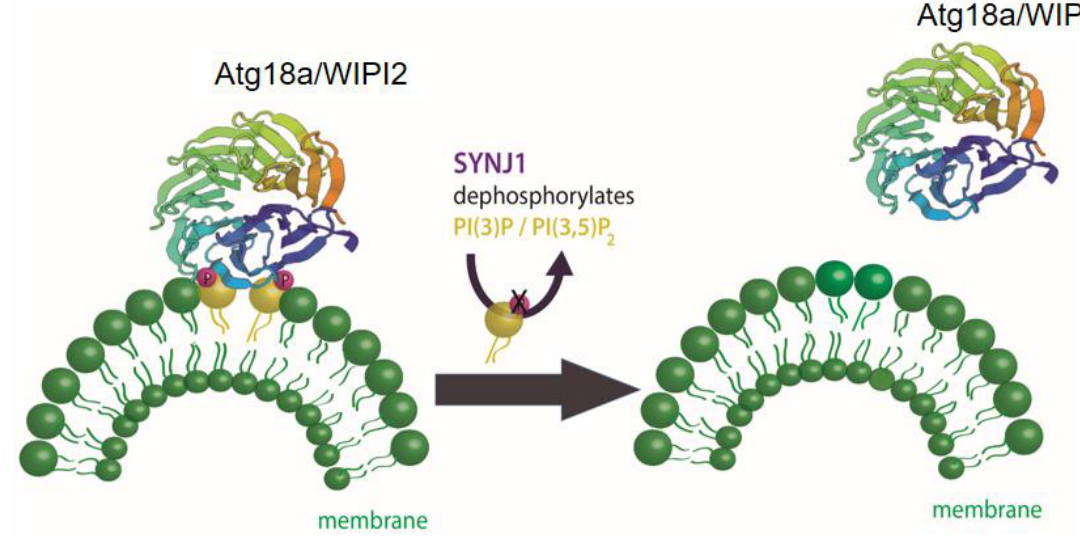
FIGURE 3: Maturation of autophagosomes relies on the turnover of PI3P/PI3,5P 2 on autophagosomal membranes. In the initial phase of the autophagy pathway the accumulation of PI3P on the phagophore is required to recruit ATG18 and its mammalian homologue WIPI2. The WD40 domain in ATG18/WIPI2 folds into a seven bladed beta-propeller that contains two phenylalanine-arginine-arginine-glycine (FRRG) motifs in the sixth blade. This FRRG residue is a two sided recognition motif with binding specificity to PI3P/PI3,5P 2 . Maturation of nascent autophagosomes requires the shedding of autophagic factors like ATG18/WIPI2. At the presynaptic terminal, the phosphatase synaptojanin1 (Synj1) dephosphory- lates PI3P/PI3,5P 2 on autophagosomal membranes leading to the removal ATG18/WIPI2. Shedding of autophagic factors like ATG18/WIPI2 from the autophagosome is important for progression of the autophagic